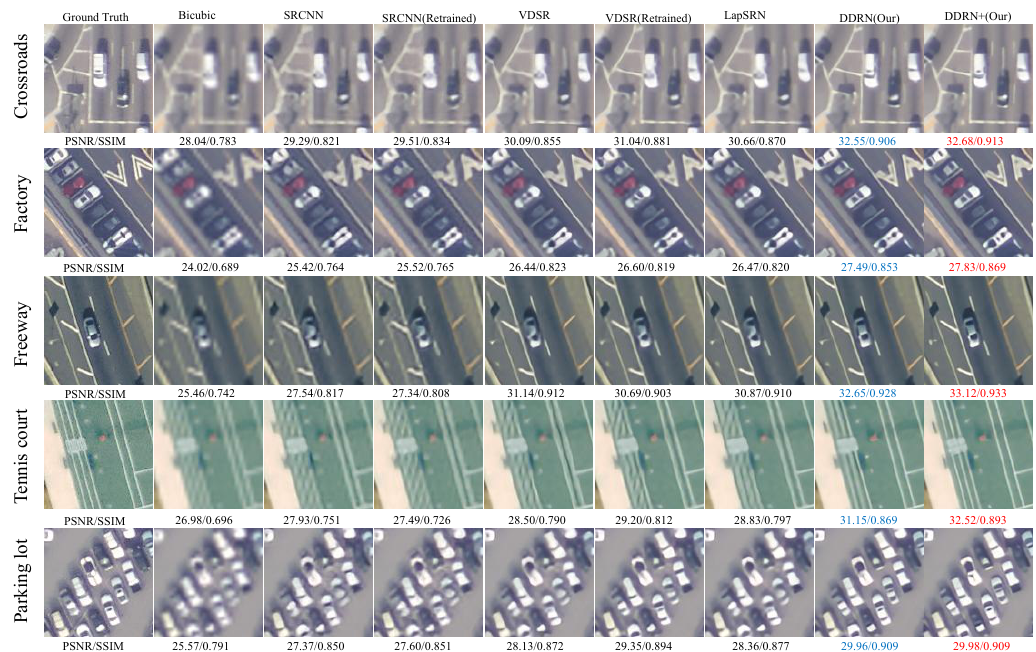
Figure 9. The reconstruction results on Kaggle Open Source Dataset and by the scale of 4. We select several different but representative scenarios, i.e., crossroads, factory, freeway, tennis court and parking lot, and then crop them into small image batches in size of 120 × 120 for demonstration. Red and blue indicate the best and the second best performance,